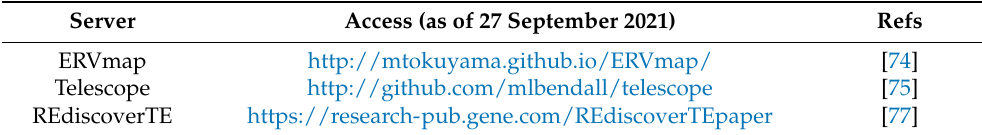
Table 4. Software tools for antigen discovery from retroelements.